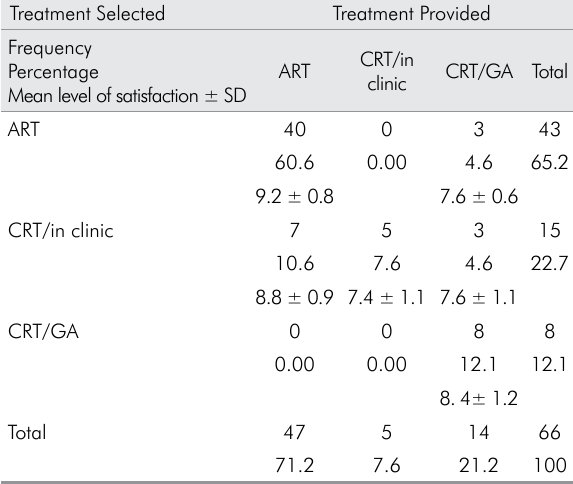
Table. Selected and provided treatment, and the level of satisfaction of patients/caregivers at 1 year follow